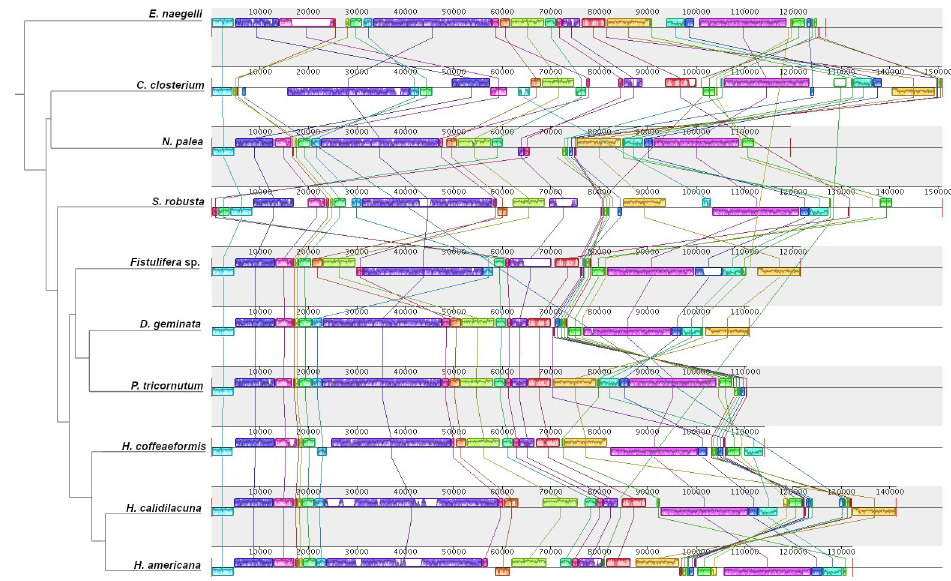
Fig 3. Gene order comparison of plastid genomes of eight biraphid pennate diatoms (three Halamphora spp. are from this study) with one copy of the inverted repeat removed prior to analysis. Alignment and resulting locally collinear blocks (LCBs) were generated using MAUVE. Relationships between taxa displayed as a cladogram to the left of the diagram are based on Fig 2.